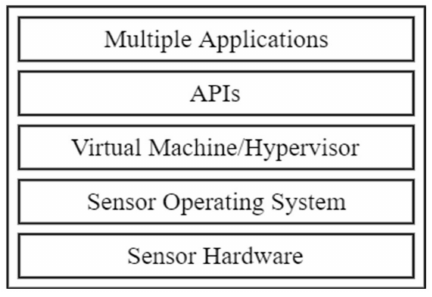
Figure 3. Multiple application execution on a single node [28].